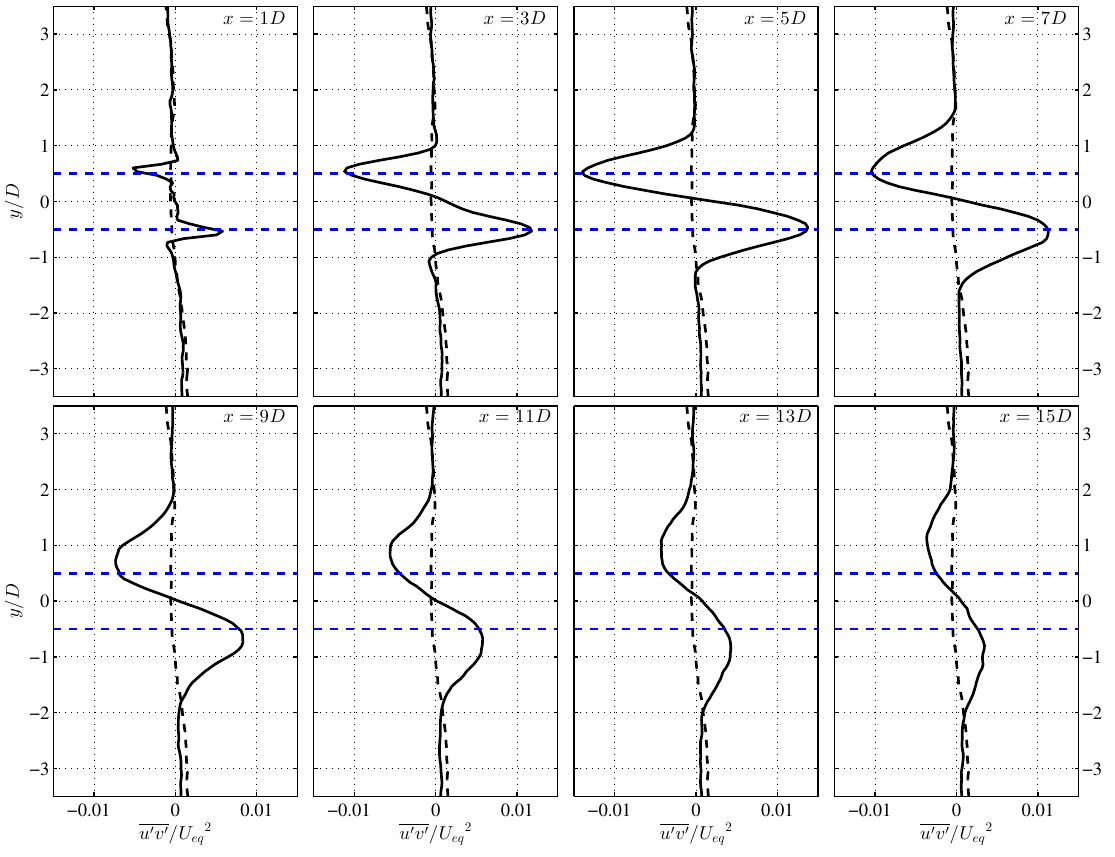
Figure 17. Horizontal profiles of the normalized lateral turbulent flux ( u (cid:48) v (cid:48) / U eq 2 ) in the x - y plane at the equator height of the turbine at different downstream positions. The black dashed line represents the inflow profile, and the blue horizontal dashed lines show the extent of the